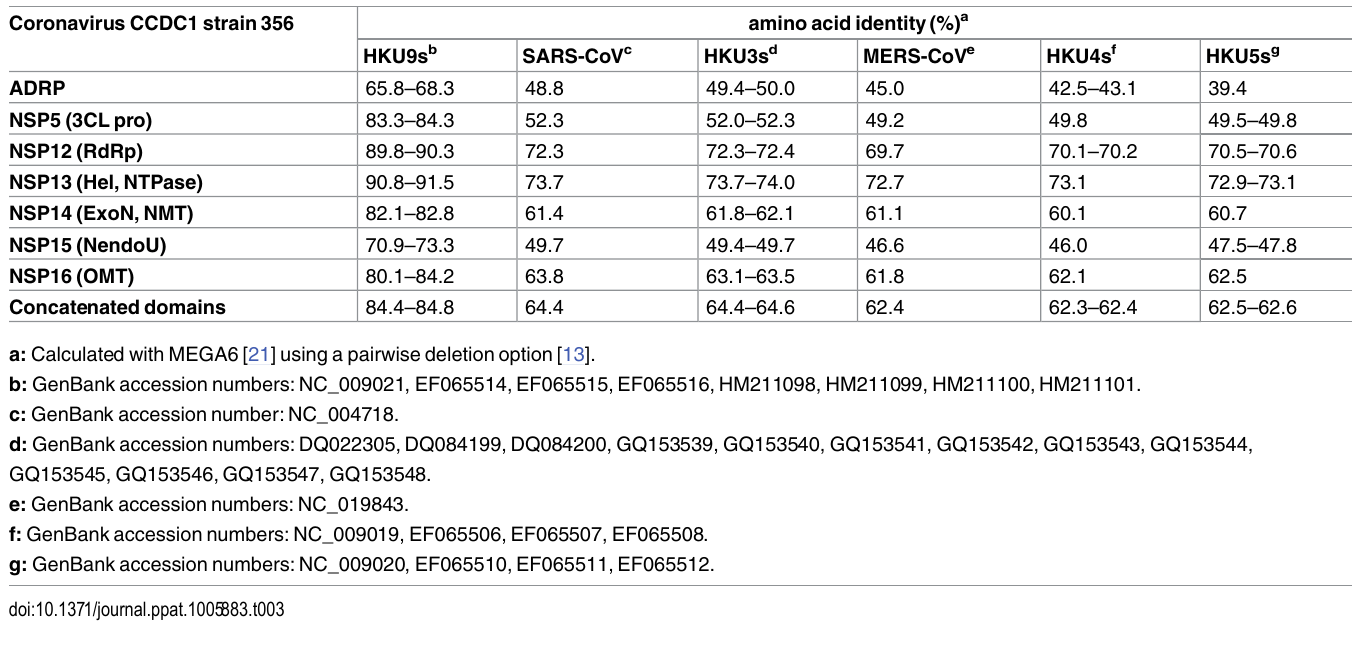
Table 3. Comparison of aminoacid identities of seven conserved replicasedomainsof Ro-BatCoV GCCDC1for speciesclassification. Coronavirus CCDC1 strain356